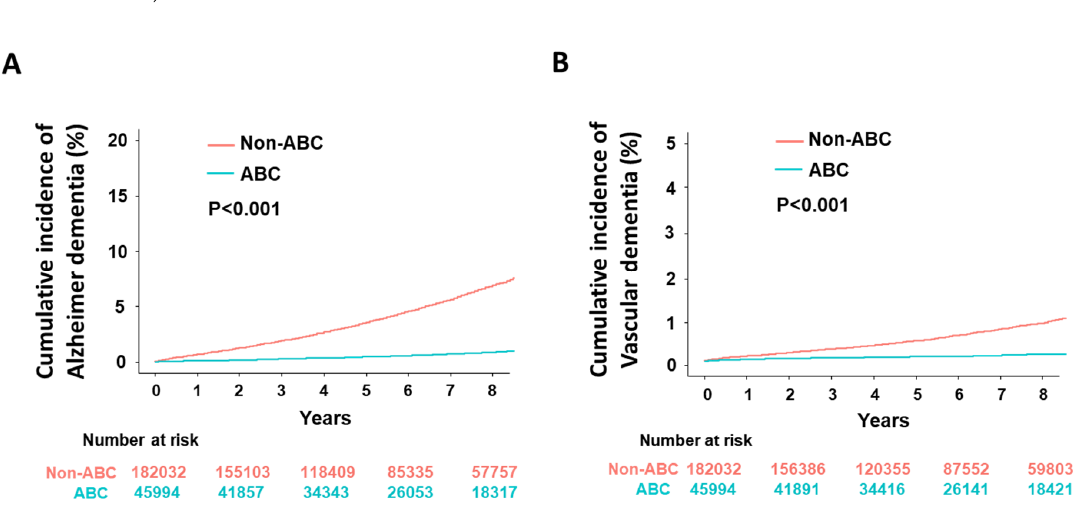
Figure 3. Cumulative incidences according to the use of integrated care (ABC). ( A ) Alzheimer’s dementia. ( B ) Vascular dementia.